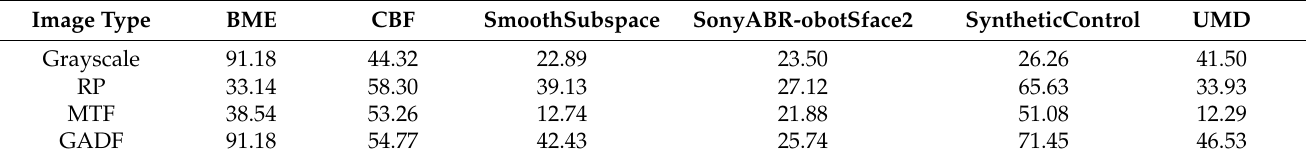
Table 2. The clustering results according to four kinds of